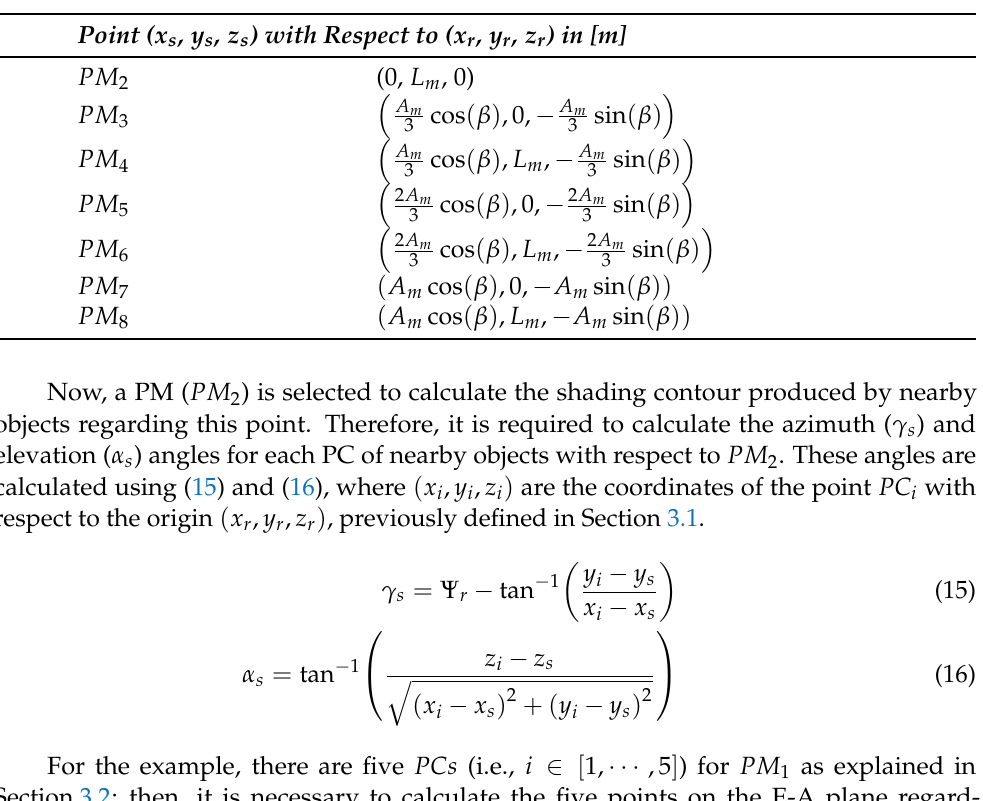
Table 1. Location of PM 1 to PM 8 for the